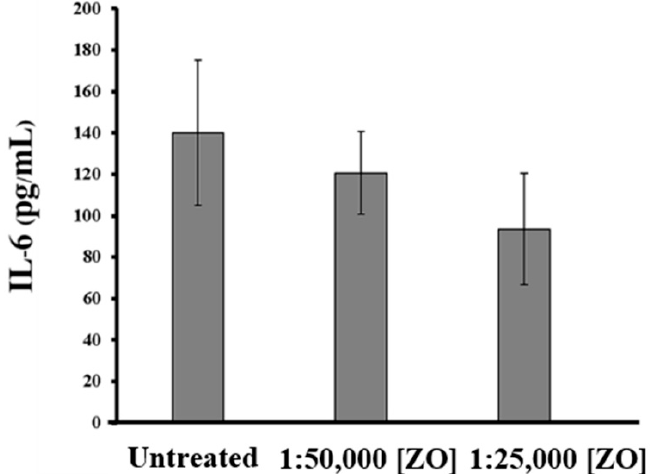
Figure 3. Measurement of IL-6 (pg/mL) in the culture media of HeLa cells incubated with various dilutions of ZO essential oil for 24 h by dilutions of ZO essential oil for 24 h by ELISA.